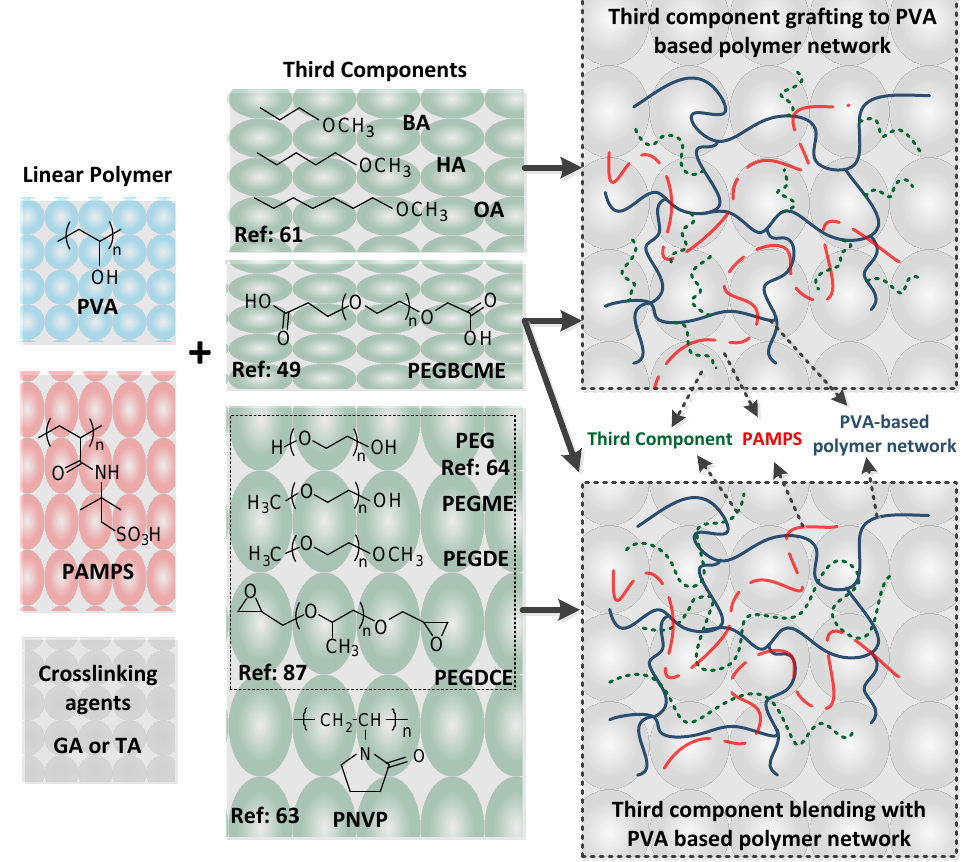
Figure 11. Scheme for illustrating the preparation of PVA/PAMPS based semi-IPN